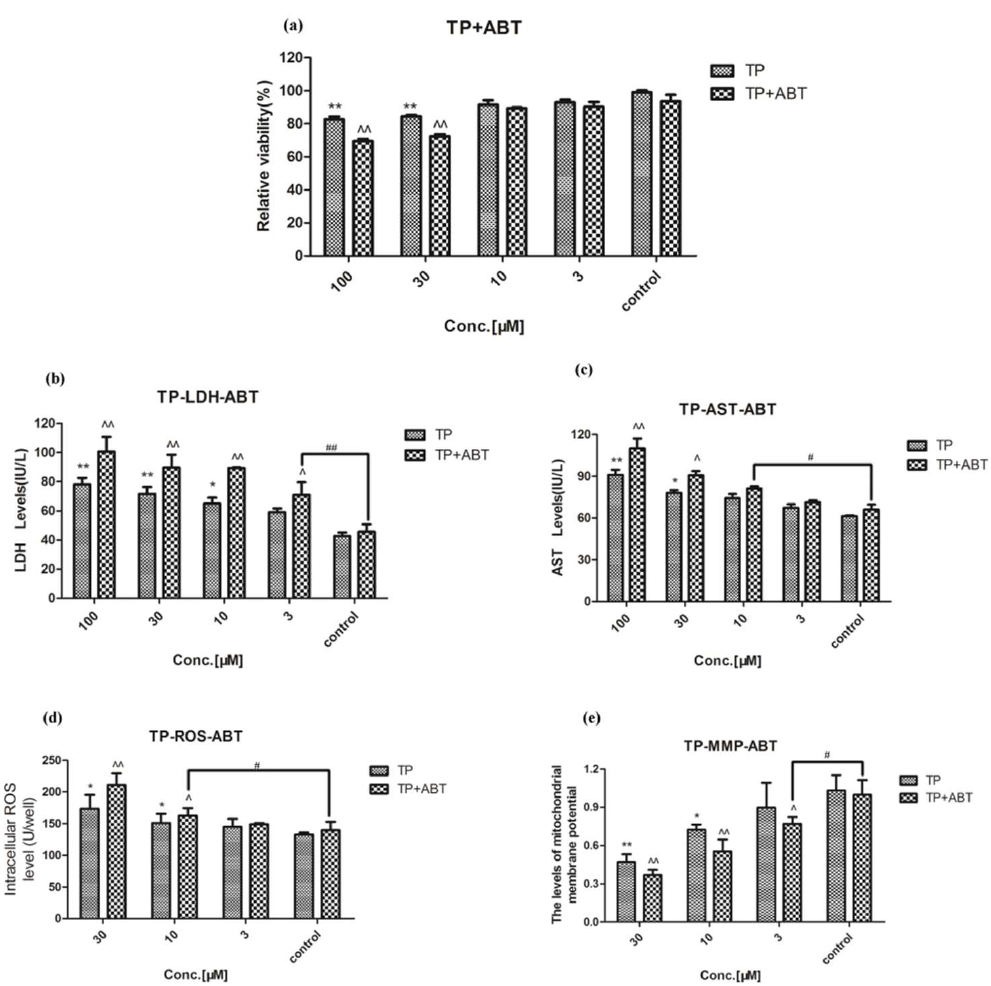
Figure 5. The effect of triptolide on cell after preincubation with ABT. ( A ) Relative viability after treatment with a variety of concentrations of triptolide. ( B ), ( C ), ( D ) Productions of LDH, AST, and ROS in primary rat hepatocytes after exposure to triptolide, respectively. ( E ) MMP levels of primary rat hepatocytes after treatment with different concentrations of triptolide. Compared with the control group, * p < 0.05, and ** p < 0.01; compared with triptolide group, ˆ p < 0.05, and ˆˆ p < 0.01; compared with ABT treated group, # p < 0.05, and ## p < 0.01.